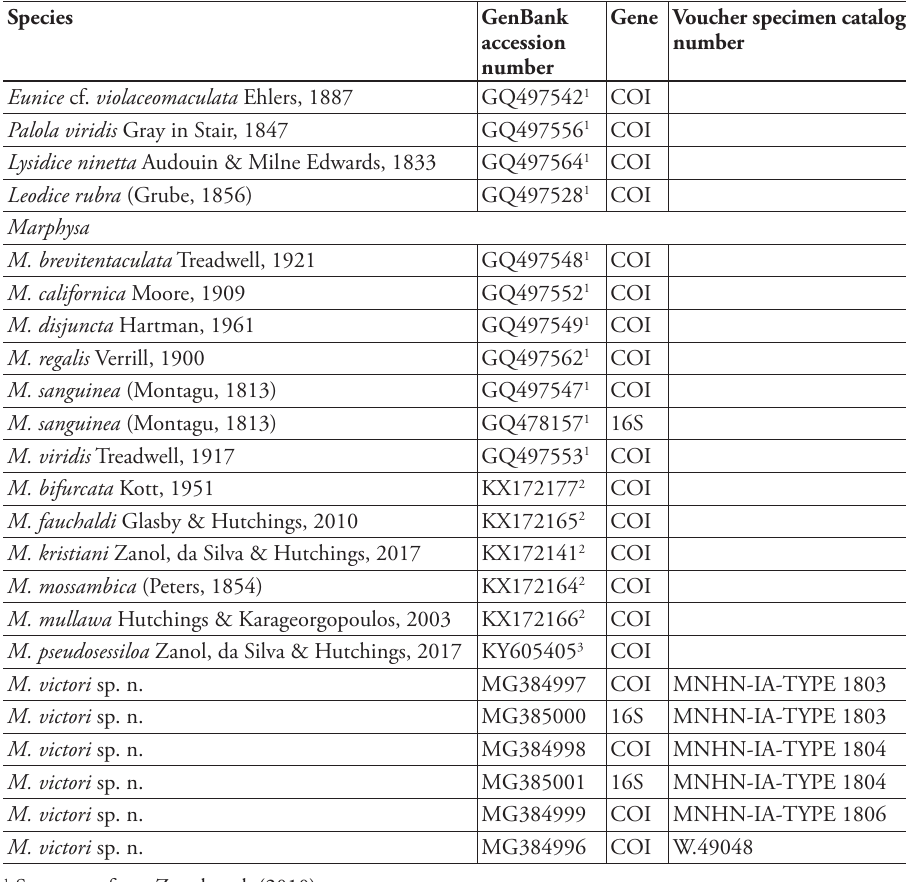
Table 1. List of terminal taxa used in molecular analysis, GenBank accession numbers, genes analysed, and voucher specimen catalog